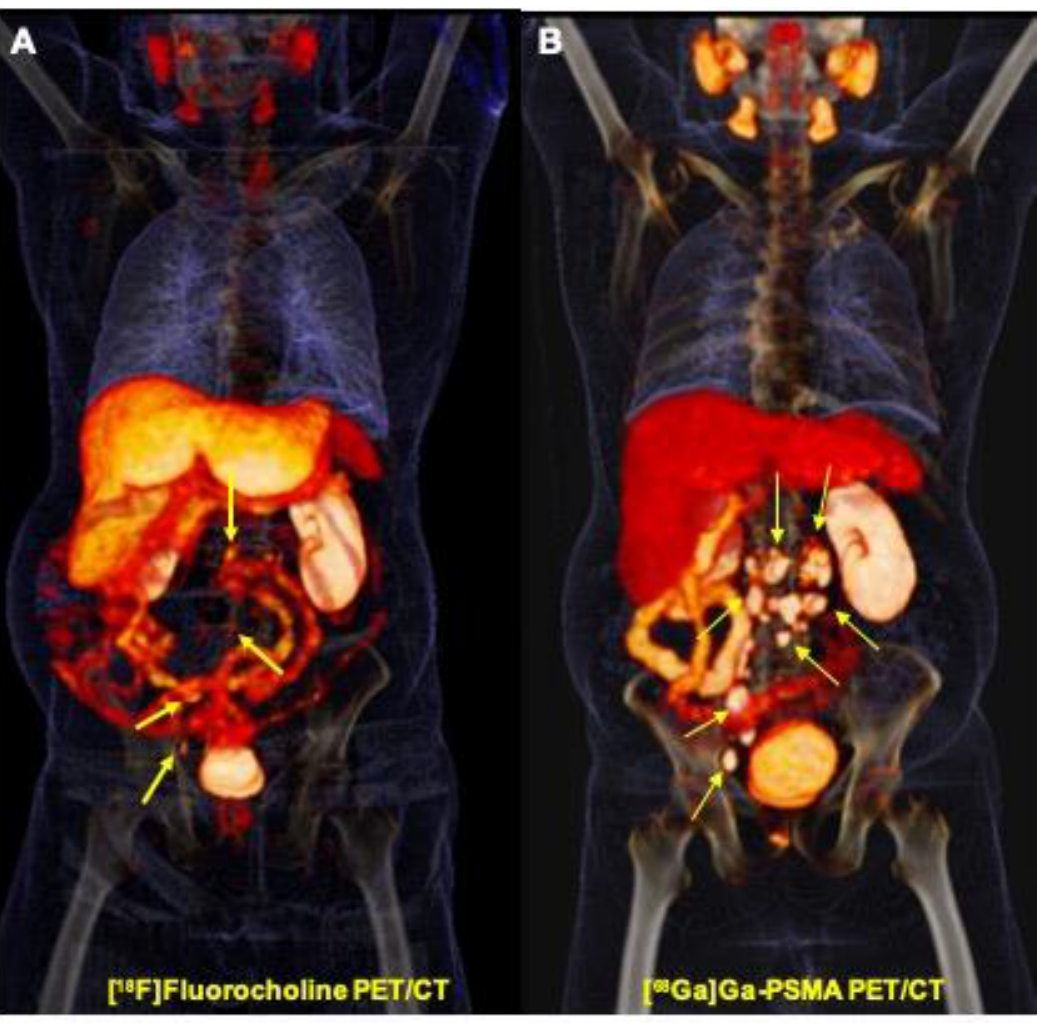
Figure 2. Prostate cancer recurrence: superior value of [ 68 Ga]Ga-PSMA PET/CT comparing to [ 18 F]Fluorocholine PET/CT in the detection of lymph node metastases (Gleason score 8, PSA: 25 ng/mL). ( A ) [ 18 F]Fluorocholine PET/CT (volume-rendered maximum intensity projection (MIP)) shows multiple small faint [ 18 F]Fluorocholine uptakes in the metastatic abdominal lymph nodes (arrows). ( B ) [ 68 Ga]Ga-PSMA PET/CT (volume-rendered MIP) shows multiple intensive [ 68 Ga]Ga-PSMA positive abdominal lymph nodes, clearly superior to [ 18 F]Fluorocholine PET/CT (arrows). [ 18 F]Fluorocholine PET/CT exclusively detected a right para-rectal lymph node, impacting the patient’s TNM score (Table 3). [ 18 F]Fluorocholine PET/CT could detect some large additional lymph nodes in a castration resistant patient as well which will be further described in detail (Table 4). Table 3. Patients with different TNM staging by two imaging modalities.